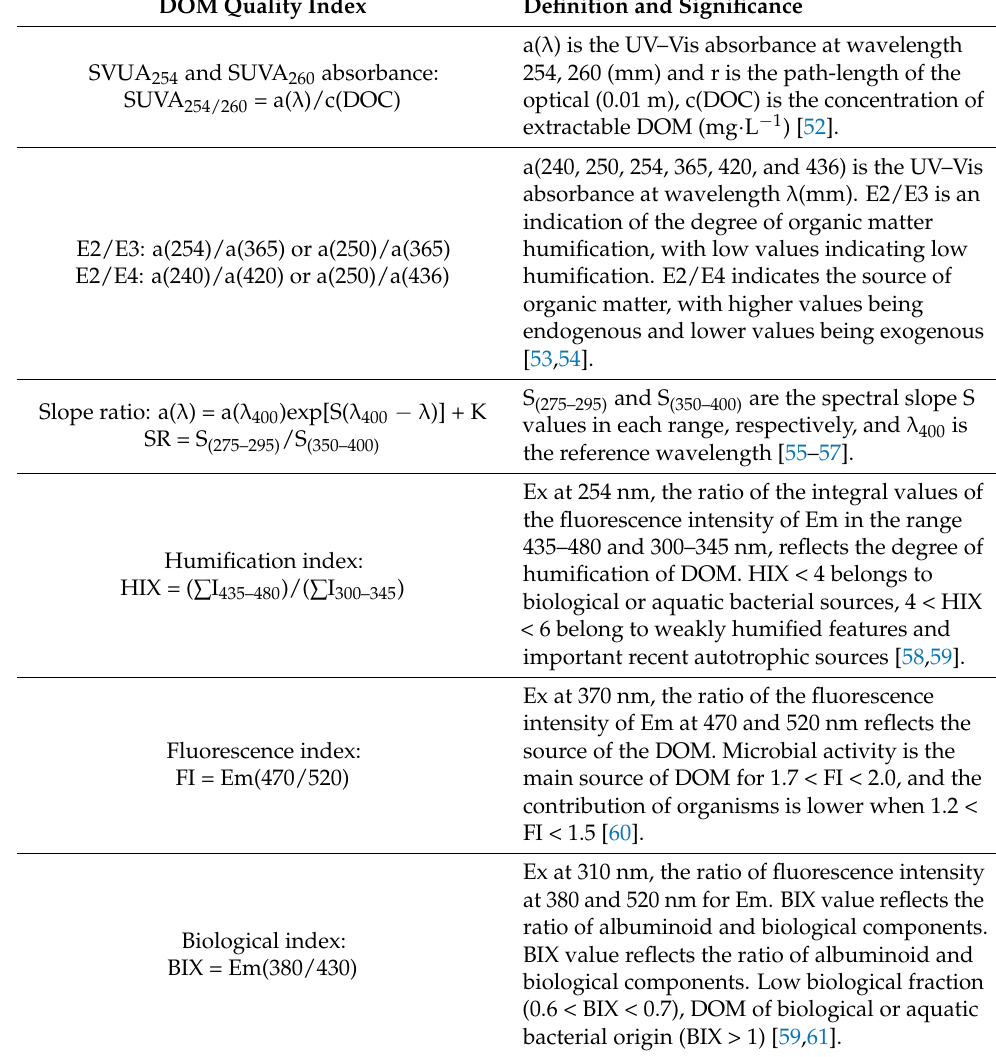
Table 2. Definition and significance of DOM optical indices and parameters used in the present